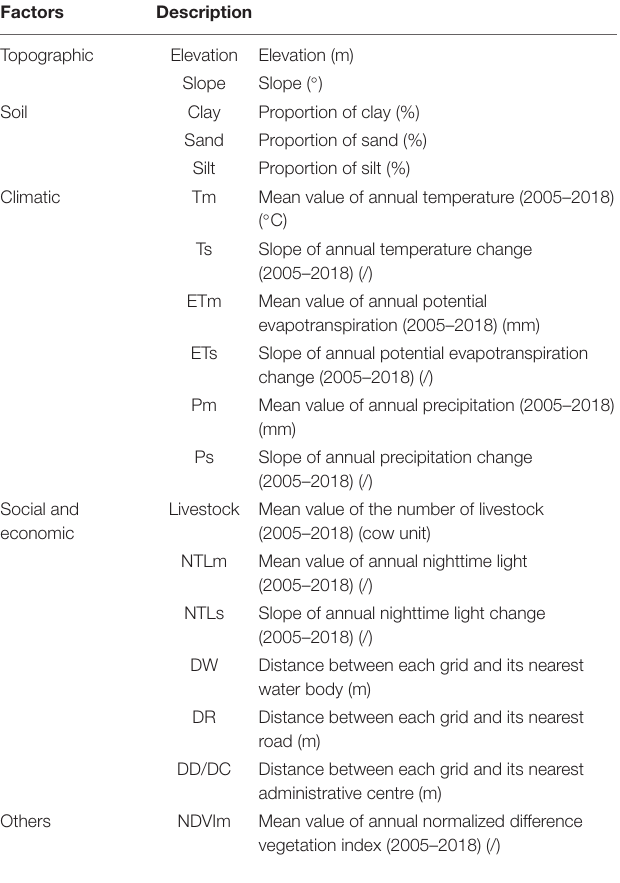
TABLE 1 | Potential factors affecting grassland